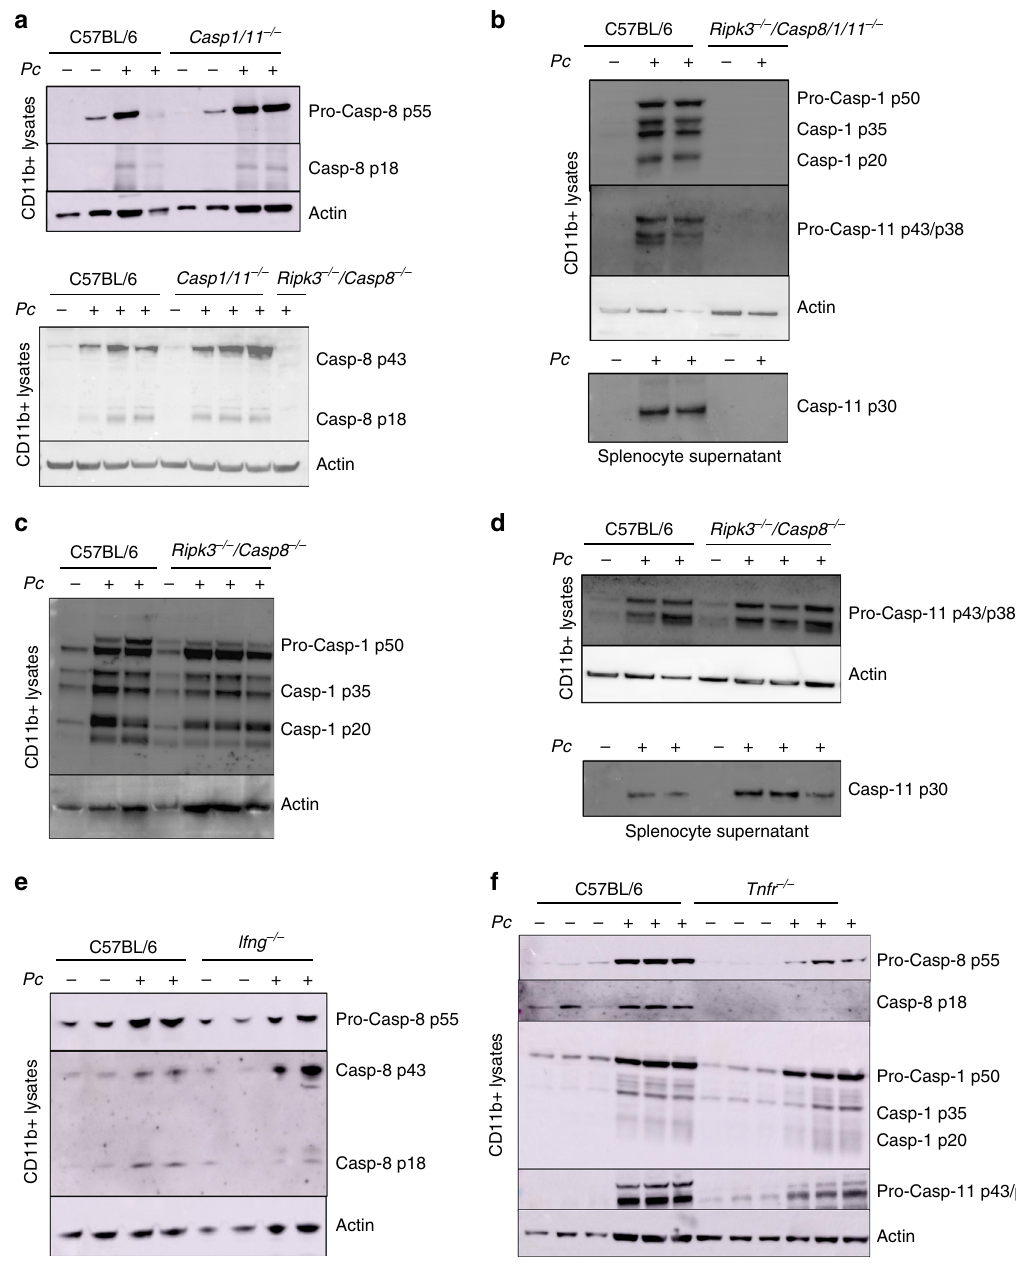
Fig. 3 Caspase-8 activation in Pc -infected mice. All results presented in this fi gure were obtained from mice either uninfected or at 8 days after infection with Pc . C57BL/6, Casp1/11 − / − , Ripk3 − / − /Casp8 − / − , Ripk3 − / − /Casp8/1/11 − / − , Ifng − / − , and Tnfr − / − mice were used in different experiments, as indicated. CD11b + cells puri fi ed from splenocytes were lysed in RIPA buffer to prepare the lysates. Alternatively, splenocytes were spin down 400 × g for 5 min to prepare supernatants. Lysates from CD11b + cells isolated from spleens of control and Pc -infected mice were analyzed by western blot using either a two distinct anti-caspase-8; b anti-caspase-1 and anti-caspase-11; c anti-caspase-1; d anti-caspase-11; and e anti-caspase-8 antibodies. b , d Alternatively, splenocytes supernatants were used to detect active caspase-11 (p30) by western blot using an anti-caspase-11 antibody. f Lysates of CD11b + cells from uninfected and infected C57BL/6 and Tnfr − / − mice were analyzed by western blot with anti-caspase-8, anti-caspase-1, and anti-caspase-11 antibodies. Blots revealed with anti- β -actin were used as loading controls. Blots are representative of two to three different experiments with similar (Fig. 4c) from both Pc- infected Ripk3 − / − /Casp8 − / − and Ripk3 − / − /Casp8/1/11 − / − mice were impaired. As observed for IL-1 β , TNF α production by splenocytes from Pc -infected mice was impaired in mice with various gene de fi ciencies (Fig. 4d).